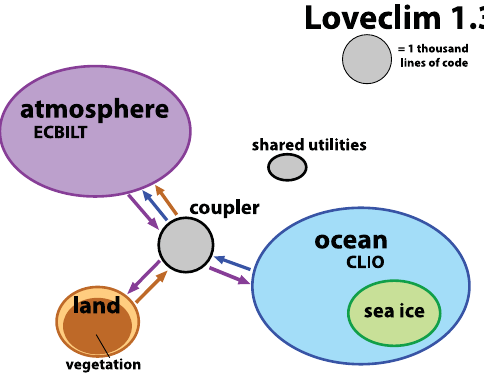
Figure 8. Architecture diagram for Loveclim